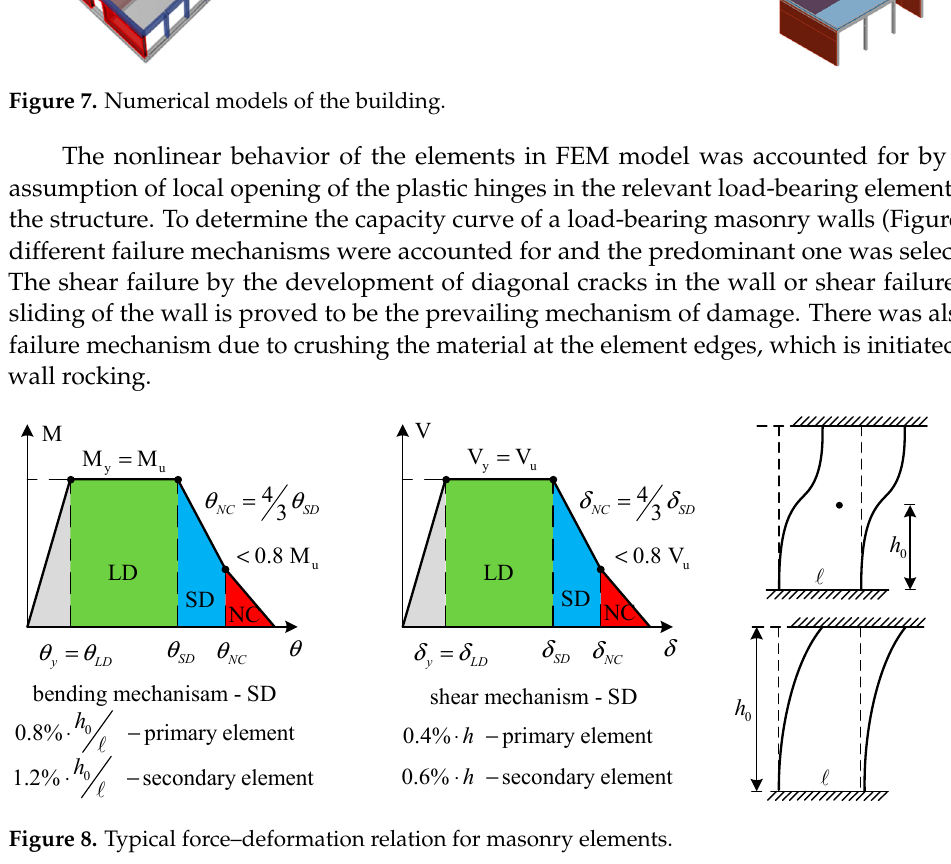
Figure 7. Numerical models of the building.